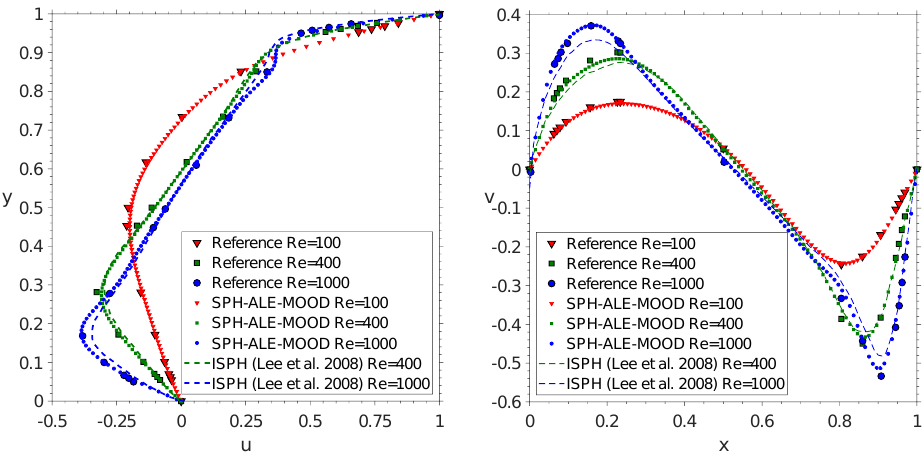
Figure 22. 2D Lid-driven cavity flow: On the left, horizontal velocity component u along x = 0.5L for Re = 100, Re = 400, and Re = 1000. On the right, vertical velocity component v along y = 0.5 L for Re = 100, Re = 400, and Re = 1000.